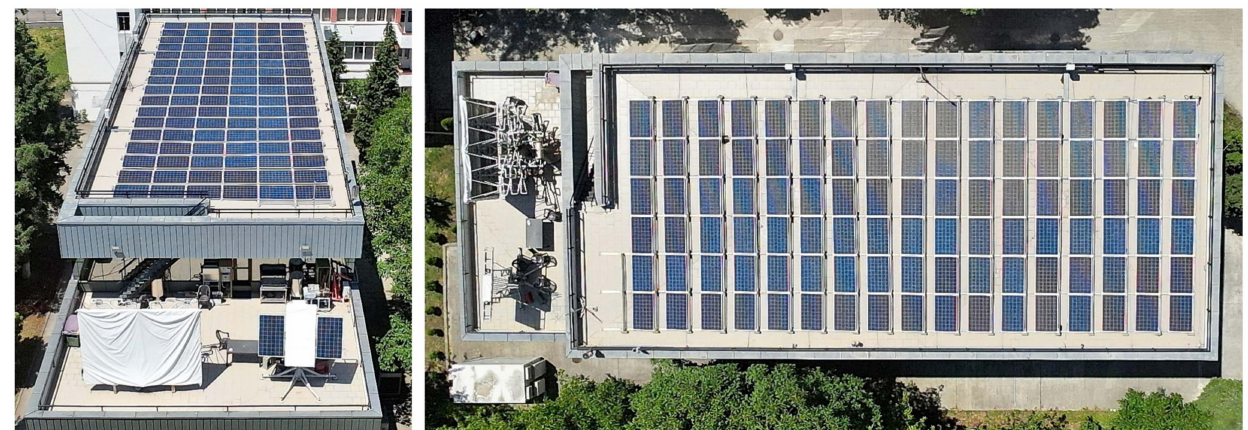
Figure 1. The CETATEA building at the National Institute for Research and Development of Isotopic and Molecular Technologies, Cluj-Napoca,